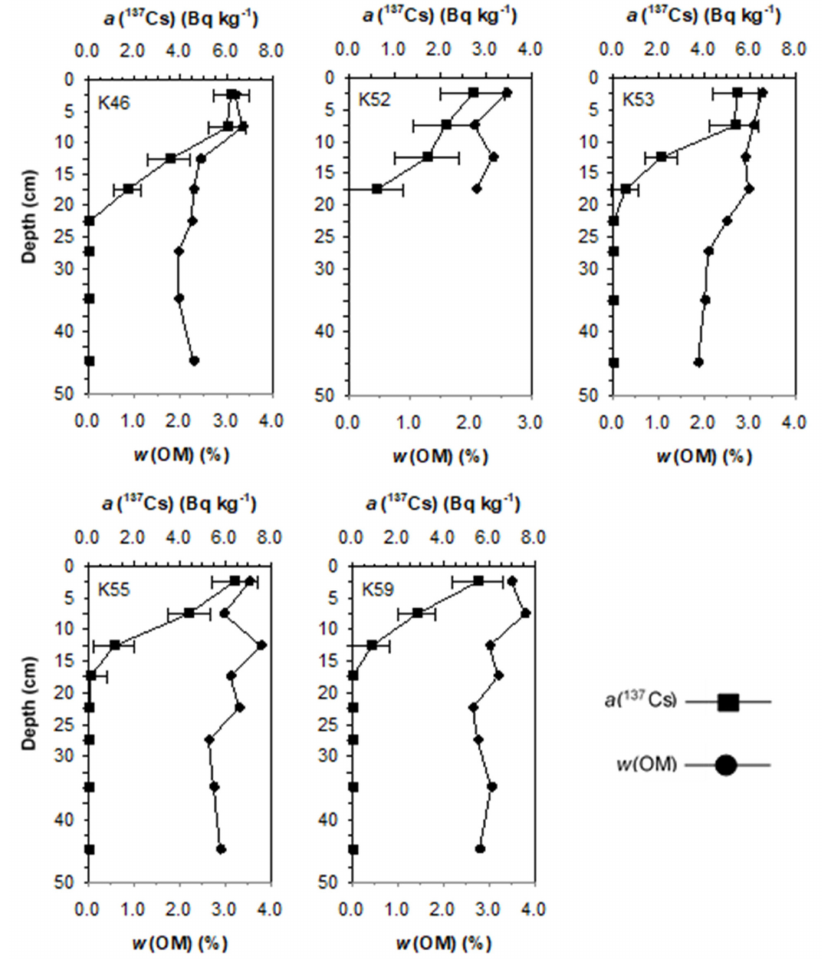
Figure 3. Undisturbed 137 Cs massic activity profiles without recognisable marker peaks and organic matter mass fraction profiles. Measurement uncertainties are expressed with k = 2 for normal